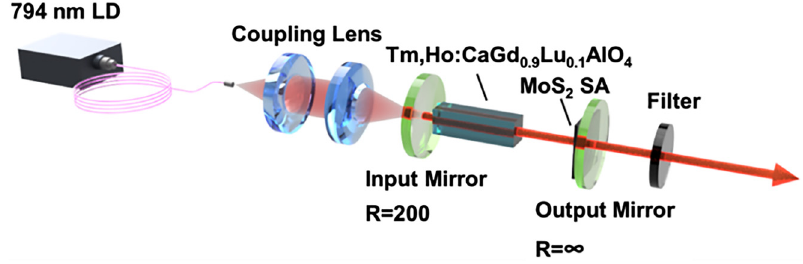
Figure 5: An illustration of the passively Q-switched Tm,Ho:CLGA laser with large- size monolayer MoS 2 as a saturable absorber.